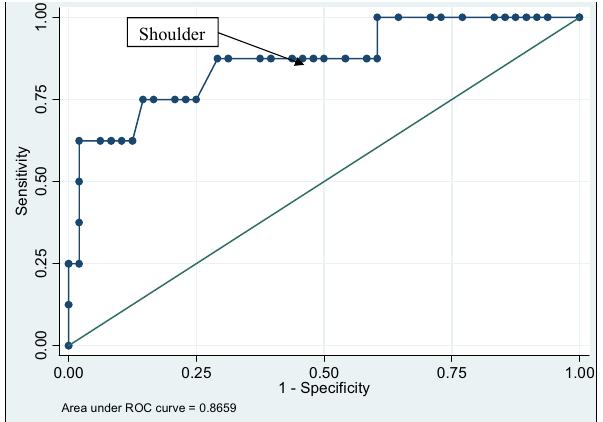
Fig. 3 Receiver Operating Characteristic (ROC) curve for different cut- pints (predicted probabilities used as cut-points). Area under ROC curve is 0.8659